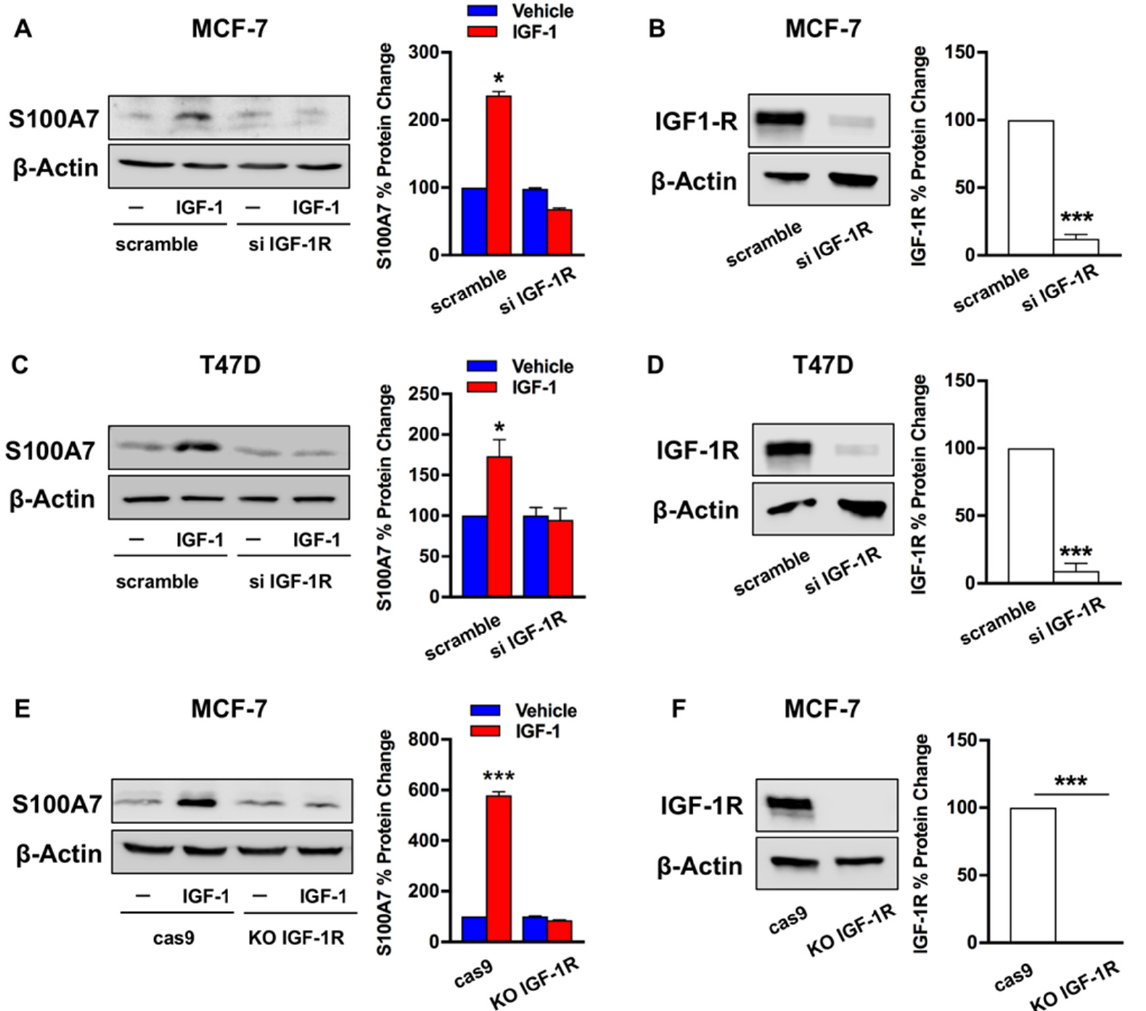
Figure 3. IGF-1R mediates the up-regulation of S100A7 expression induced by IGF-1. The upregulation of S100A7 protein expression observed in MCF-7 ( A ) and T47D ( C ) cells treated with vehicle (–) or IGF-1 (10 nM IGF-1, 48 h) was abrogated by silencing IGF-1R, as evidenced by western blotting. Representative immunoblots showing the efficiency of IGF-1R silencing in MCF-7 ( B ) and T47D cells ( D ). The up-regulation of S100A7 protein levels induced by IGF-1 (10 nM, 48 h) was prevented in MCF-7 cells knock out for IGF-1R (MCF-7 KO-IGF1R) compared to MCF-7 control cells (MCF-7 cas9), as indicated ( E ). Representative immunoblot showing the efficiency of IGF-1R knock-out ( F ). β -actin serves as loading control. Side panels show densitometric analysis of the blots normalized to β -actin. Data shown are the mean ± SEM of at least two independent experiments. (*) p < 0.05; (***) p < 0.001.